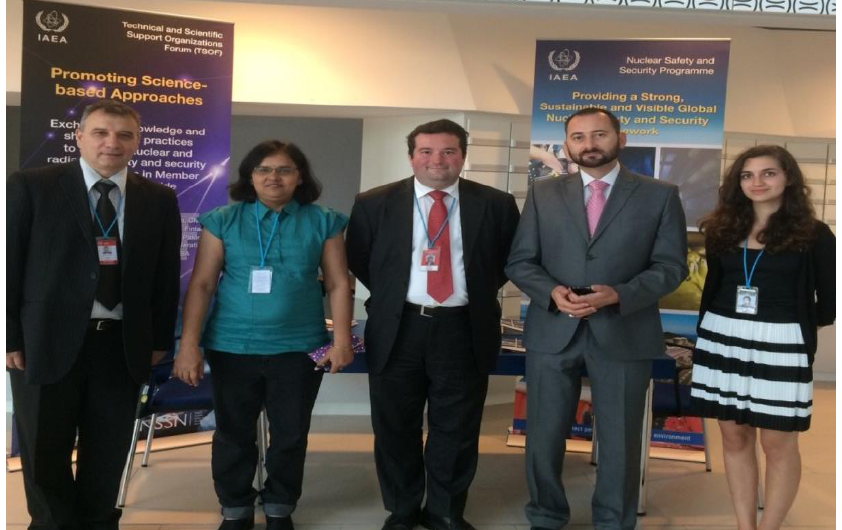
Figure 4. Alpana Goel, deputy director and head of AINST, (second from left) at the annual meeting of INSEN on August 10-12, 2015, held at the IAEA in Vienna,